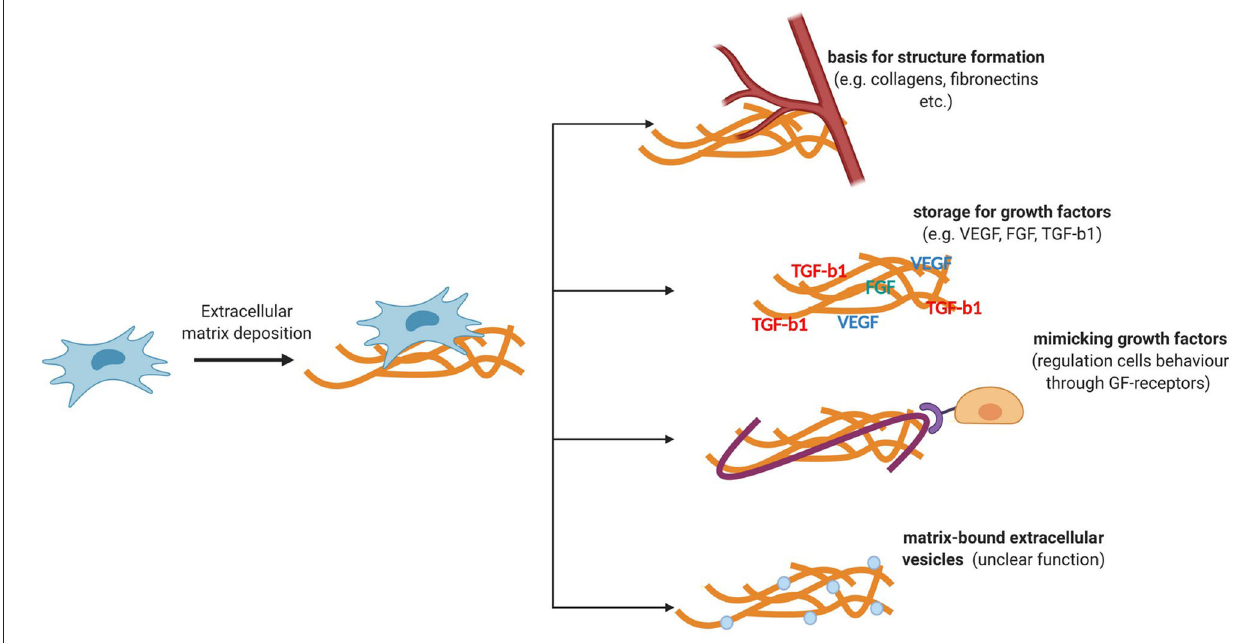
FIGURE 2 | Functions of ECM components secreted by MSCs. ECM is a three-dimensional structure consisting of collagen, fibronectin, elastin, glycosaminoglycans, and various glycosylated proteins that are capable of transmitting mechanical and biochemical cues to cells. ECM stiffness can regulate the behavior of niche cells. The ability of the ECM to transmit biochemical signals is also due to its ability to deposit regulatory molecules and matrix-bounded vesicles, protecting them from degradation and localizing their effects.